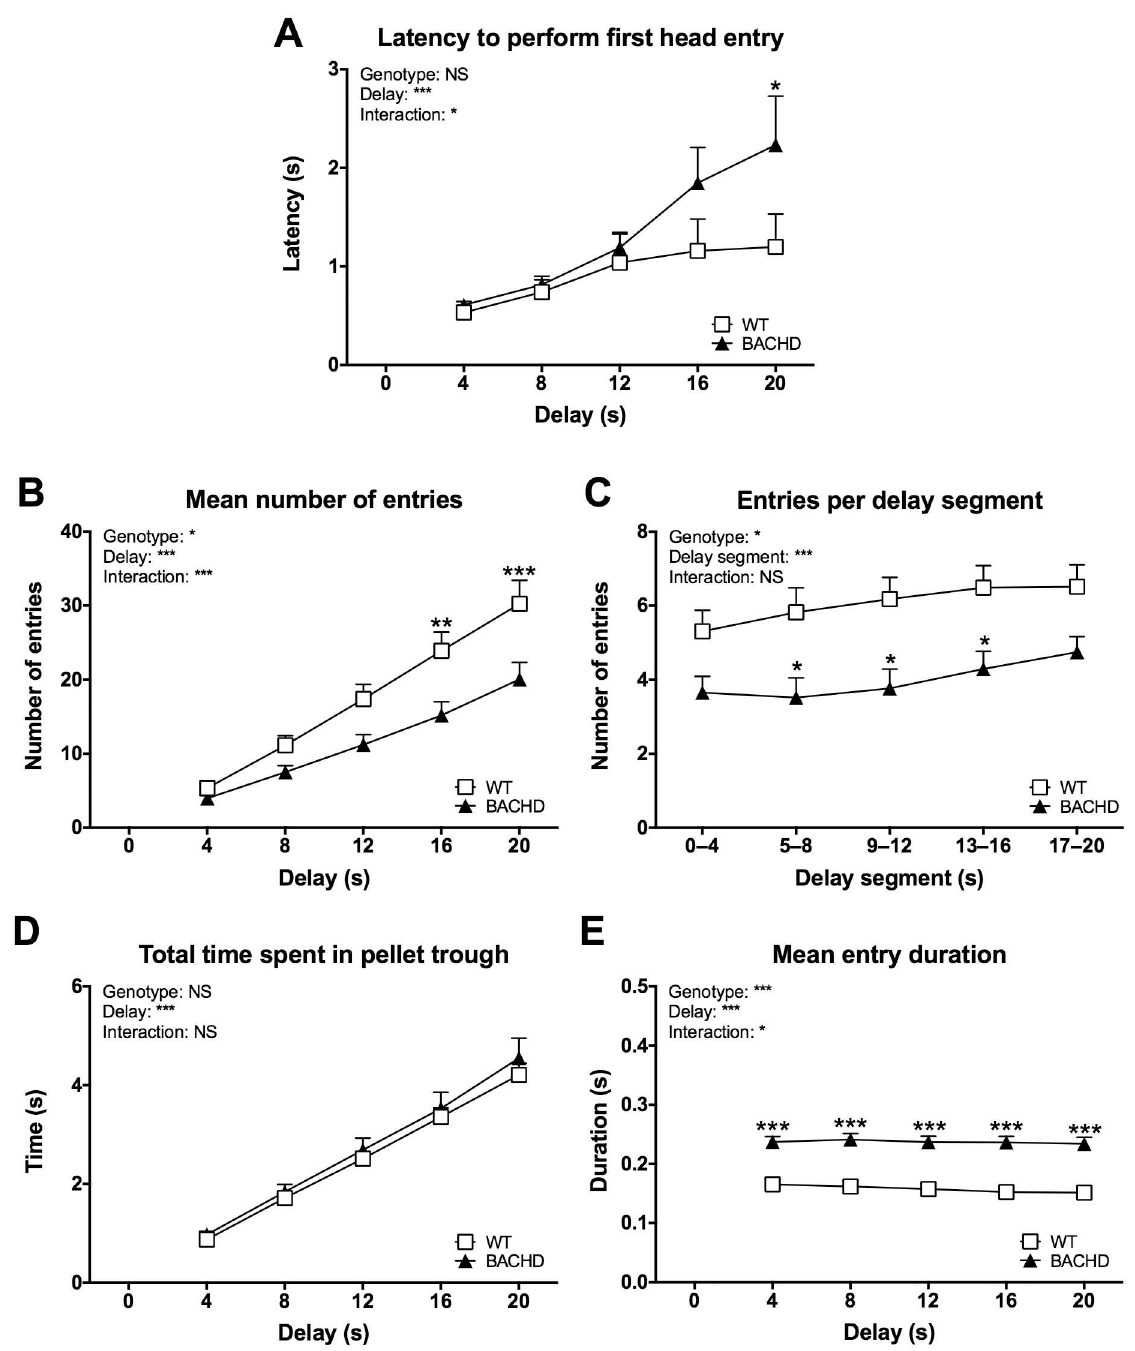
Fig 5. Head entry behavior during delays of the delayed alternation protocol. The graphsshowseveral aspectsof head entries made into the pellet troughduringdelaysteps of the delayedalternation test. Curves were createdbasedon the overall performanceat all test ages, as no significant changewith age was foundfor the parameters. (C) concernsthe 20-seconddelay step. Graphs indicategroup mean plus standarderror. Results from two-wayrepeated measures ANOVA are shown insidethe graphs. Resultsfrom post-hoc analysisare indicatedin case significant genotypedifferenceswere found. * ( P < 0.05) ** ( P < 0.01) *** ( P < 0.001).